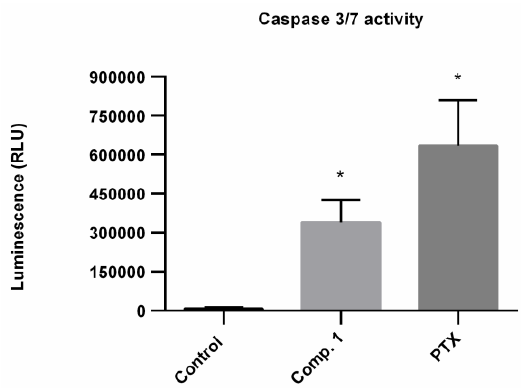
Figure 8. Caspase 3/7 activation after treatment with Compound 1 at 21.3 µM (12 µg/mL) for 72 h and PTX (20 nM) positive control on Hep3B cells. * p < 0.05 compared with the control cells group.